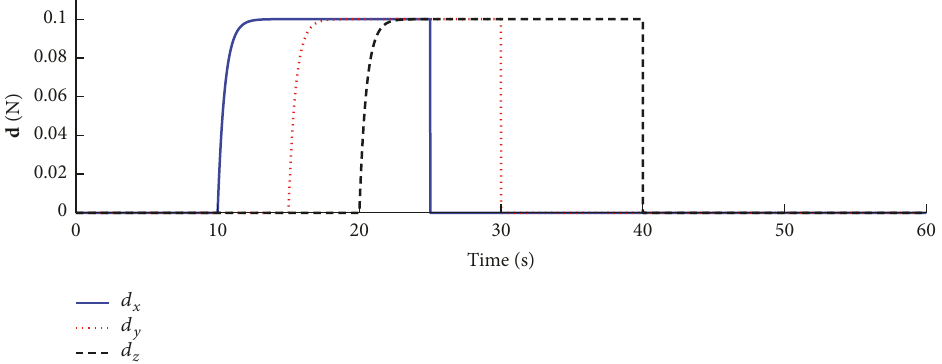
Figure 6: Profile of the disturbance forces applied to the load and expressed in the inertial frame I